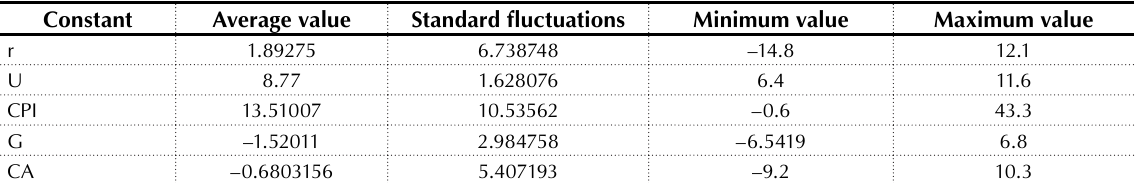
Table 2. Descriptive statistics of the MSP model main key indices